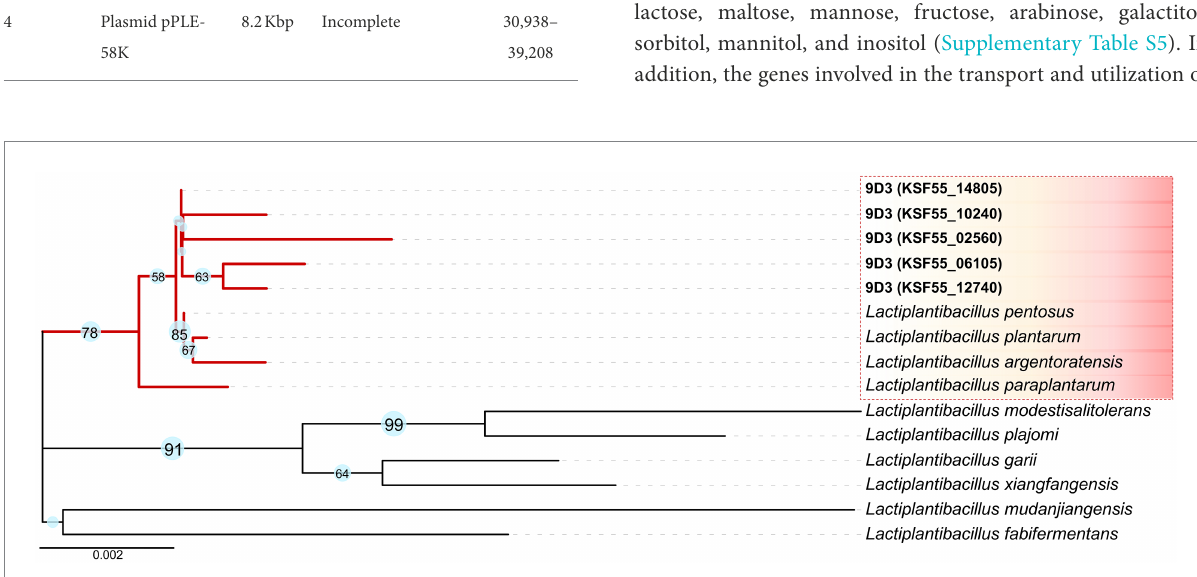
FIGURE 2 16S rRNA gene marker analysis of the 9D3 strain and the selected type strains of closely related species. The phylogenetic tree was constructed by the Neighbor-Joining method with 1,000 bootstrap replicates using MEGA11 (Saitou and Nei, 1987; Stecher et al., 2020; Tamura et al., 2021). Evolutionary distances in the units of the number of base substitutions per site were computed using the Kimura 2-parameter method (Kimura, 1980), and the visualization of the phylogenetic tree was drawn by iTOL version 5 (Letunic and Bork, 2021), in which only bootstrap values ≥ 50% are shown next to the